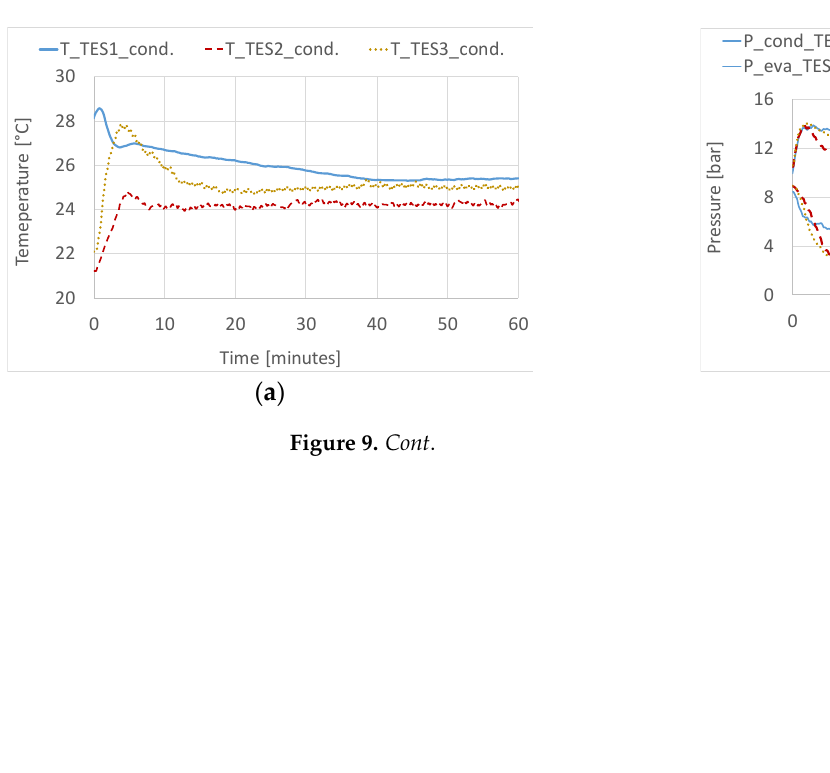
Figure 9. A summary of the results three-fluids HEX mode ( a ) temperature at the condenser, ( b ) pressure at the condenser and evaporator, and ( c ) cooling load at the evaporator. 3.7. Effectiveness, SOC, and COP during the Three-Fluids HEX Operating Mode Figure 10 summarizes the results obtained in the three-fluids HEX operating mode based on the SOC (energy level in the module), the effectiveness of the modules, and COP of the system at thermal equilibrium. The energy level (SOC) is higher in TES (cid:2869) than in TES (cid:2870) and TES (cid:2871) . This is expected since thermal equilibrium was achieved at a lower tem- perature value in TES (cid:2869) . The HTF net power is the highest in TES (cid:2869) , followed by TES (cid:2870) , and finally TES (cid:2871) . All modules could achieve an effectiveness value higher than 0.5, and the highest effectiveness value of around 0.83 was obtained in TES (cid:2869) , followed by TES (cid:2870) around 0.63, and finally TES (cid:2871) with 0.56. A COP around 4 was achieved for all the mod- ules, although TES (cid:2869) and TES (cid:2870) showed the highest COP of 4.4, whereas the COP of TES (cid:2871) was around 4.